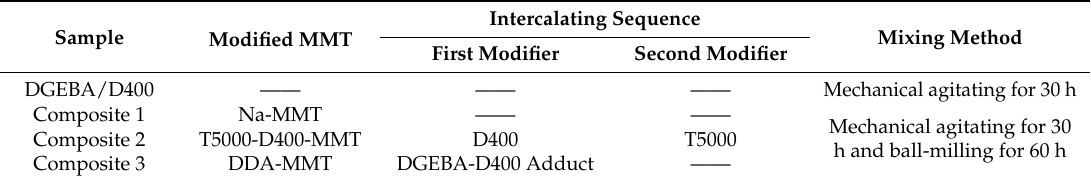
Table 1. Preparation methods for DGEBA/D400 resin and MMT/DGEBA nanocomposites at 3 wt % clay